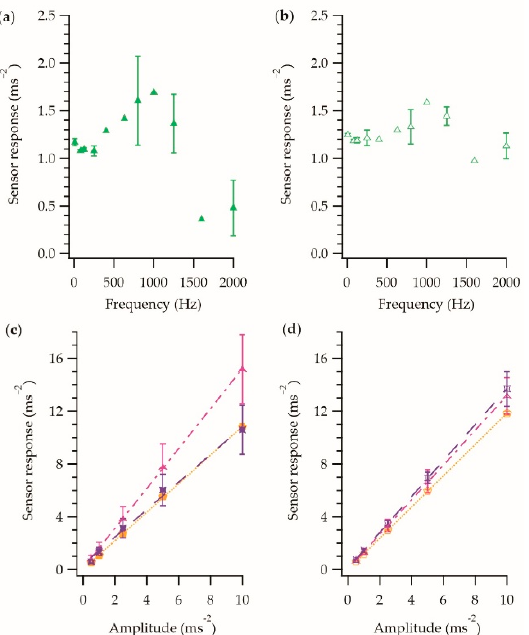
Figure 7. Sensor response of a vibration-sensing E-yarn constructed with a large diameter knit